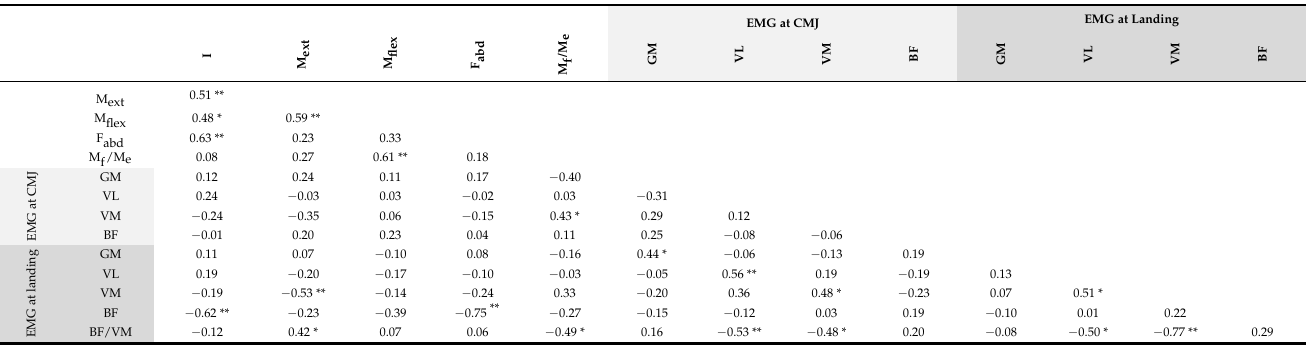
Table 1. Pearson product moment correlations among all mechanical and EMG variables. * Significant at p = 0.05. ** Significant at p =